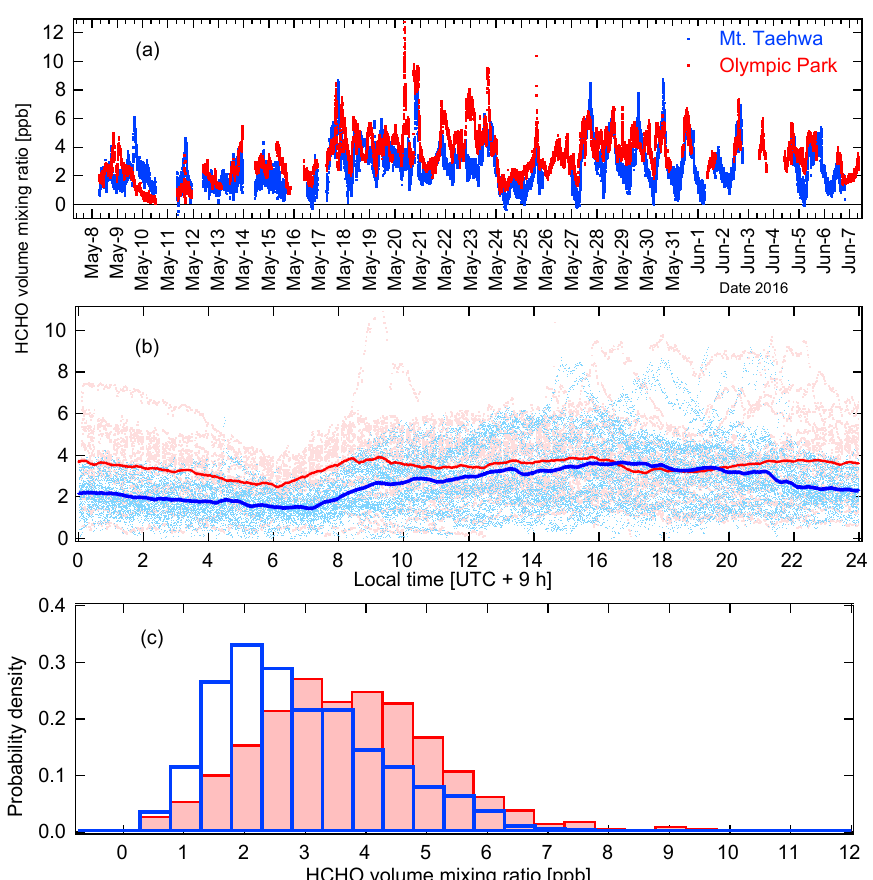
Figure 3. (a) In situ HCHO volume mixing ratios measured at Olympic Park and Mt. Taehwa; (b) diurnal variation of HCHO volume mixing ratios at Olympic Park and Mt. Taehwa (solid lines represent running averaged data); (c) overlapping histograms of the HCHO distribution at Olympic Park and Mt. Taehwa during